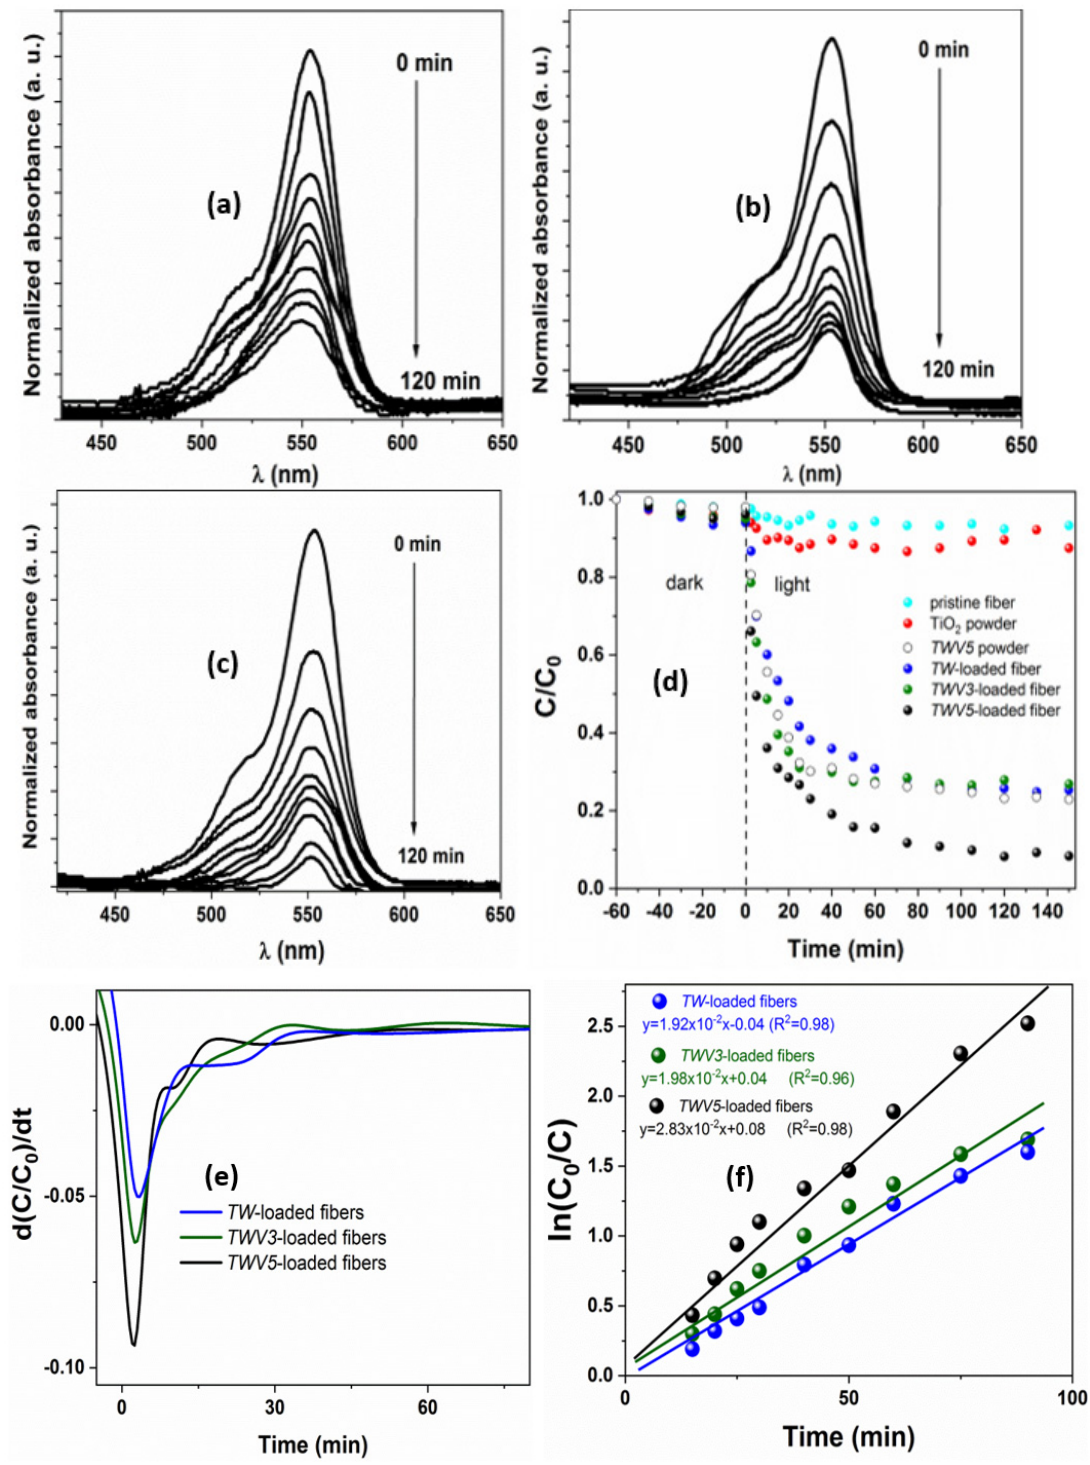
Figure 9. Change in absorbance spectra of RhB dye, using ( a ) TW -, ( b ) TWV3 - and ( c ) Figure 7. Change in absorbance spectra of RhB dye, using ( a ) TW-, ( b ) TWV3- and ( c ) TWV5-loaded TWV5 -loaded fibers nanocomposites. ( d ) Dye photodegradation dynamics using MON -loaded fi- fibers nanocomposites. ( d ) Dye photodegradation dynamics using MON-loaded fibers, under visible bers, under visible light excitation. The TiO (cid:2870) and TWV5 powders (with higher and lower light excitation. The TiO 2 and TWV5 powders (with higher and lower bandgap, respectively) were bandgap, respectively) were also tested for comparison purposes. ( e ) Derivative of the relative also tested for comparison purposes. ( e ) Derivative of the relative concentration of RhB with time. ( f ) Application of the pseudo-first-order kinetic model to the experimental